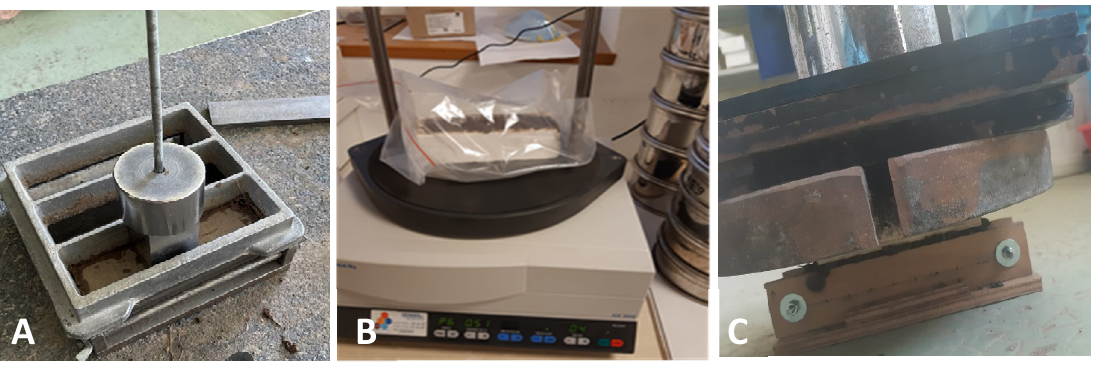
Figure 6. Bricks dynamic compaction ( A ), sieve shaker ( B ), and static compaction( C ).